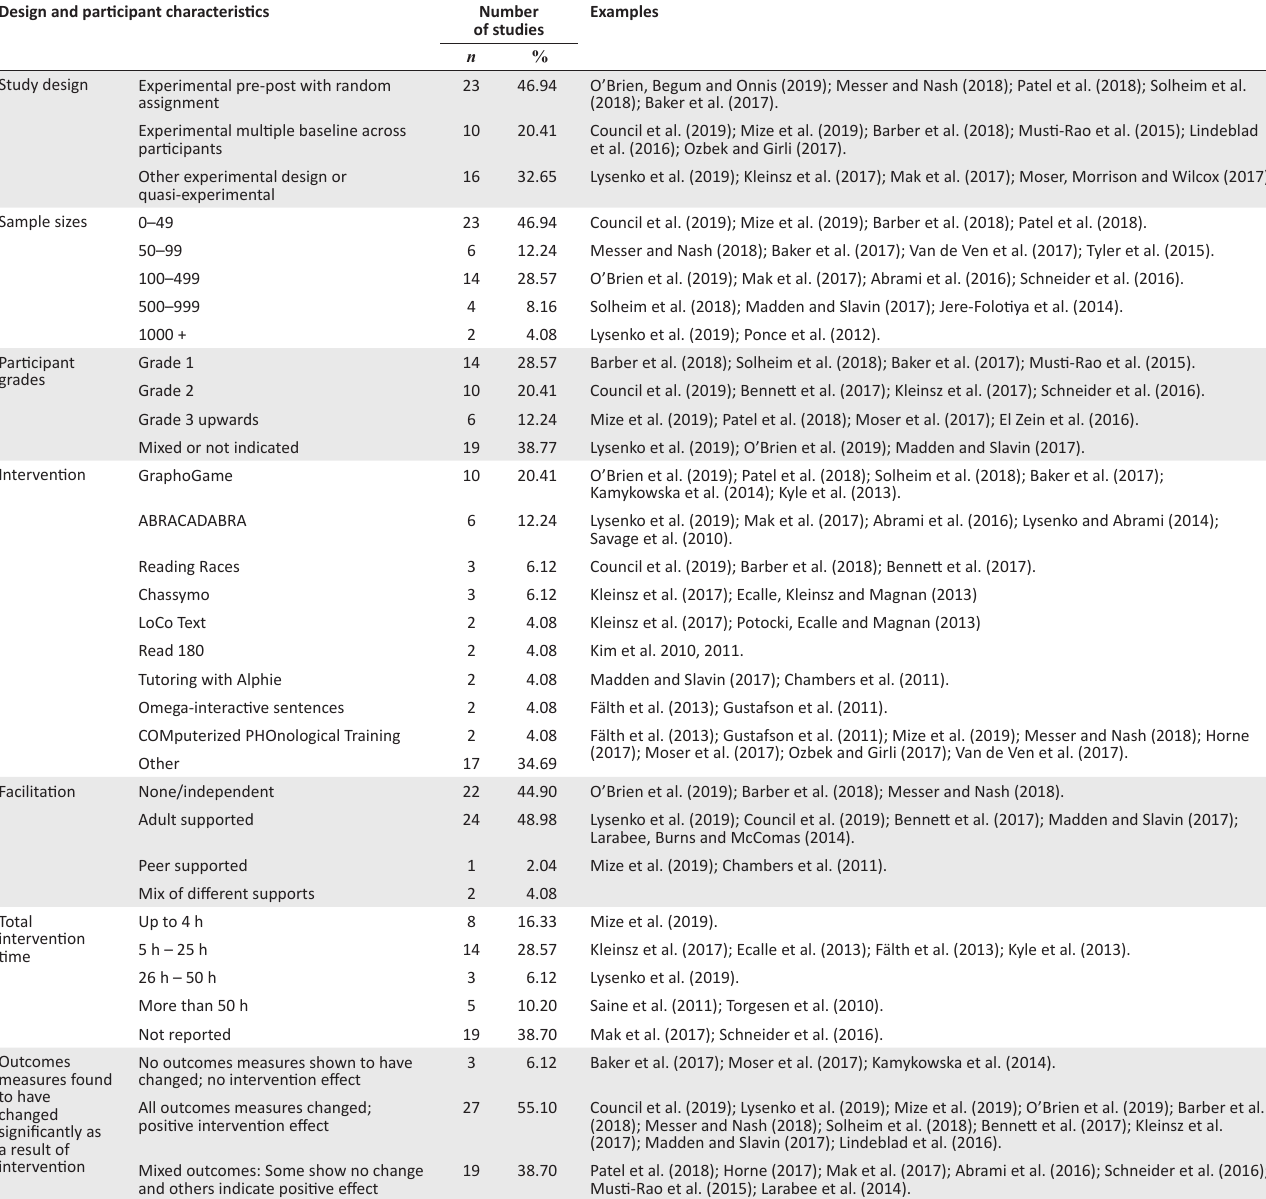
TABLE 1: Design and participant characteristics of studies included in the information and communication technology-based reading intervention scoping review. Design and participant